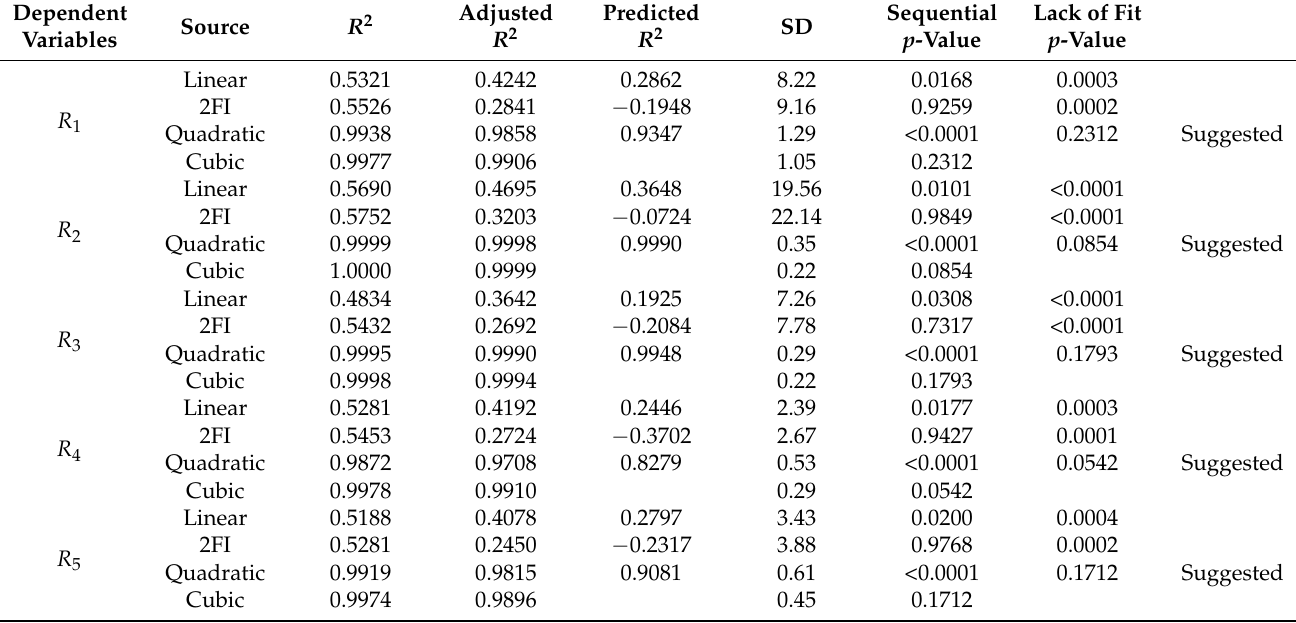
Table 3. Regression analysis and response regression equation results for the final proposed